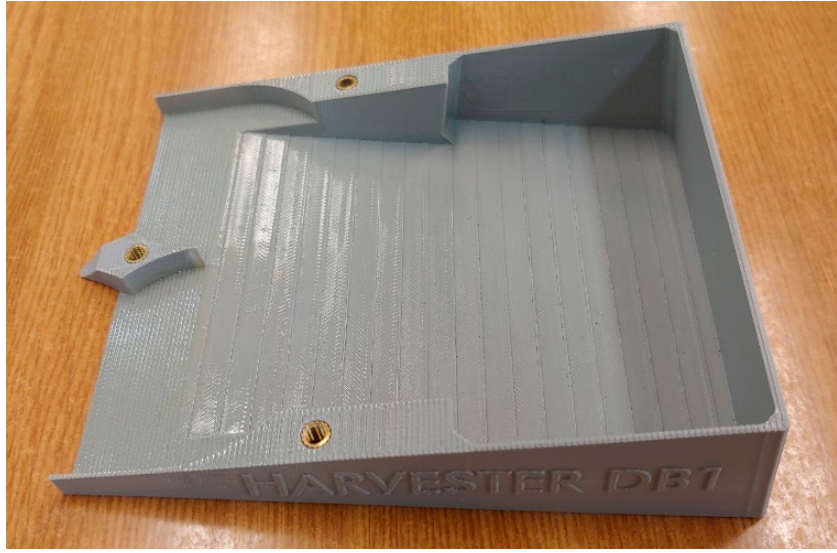
Figure 6. Harvester main body produced using the FDM method.